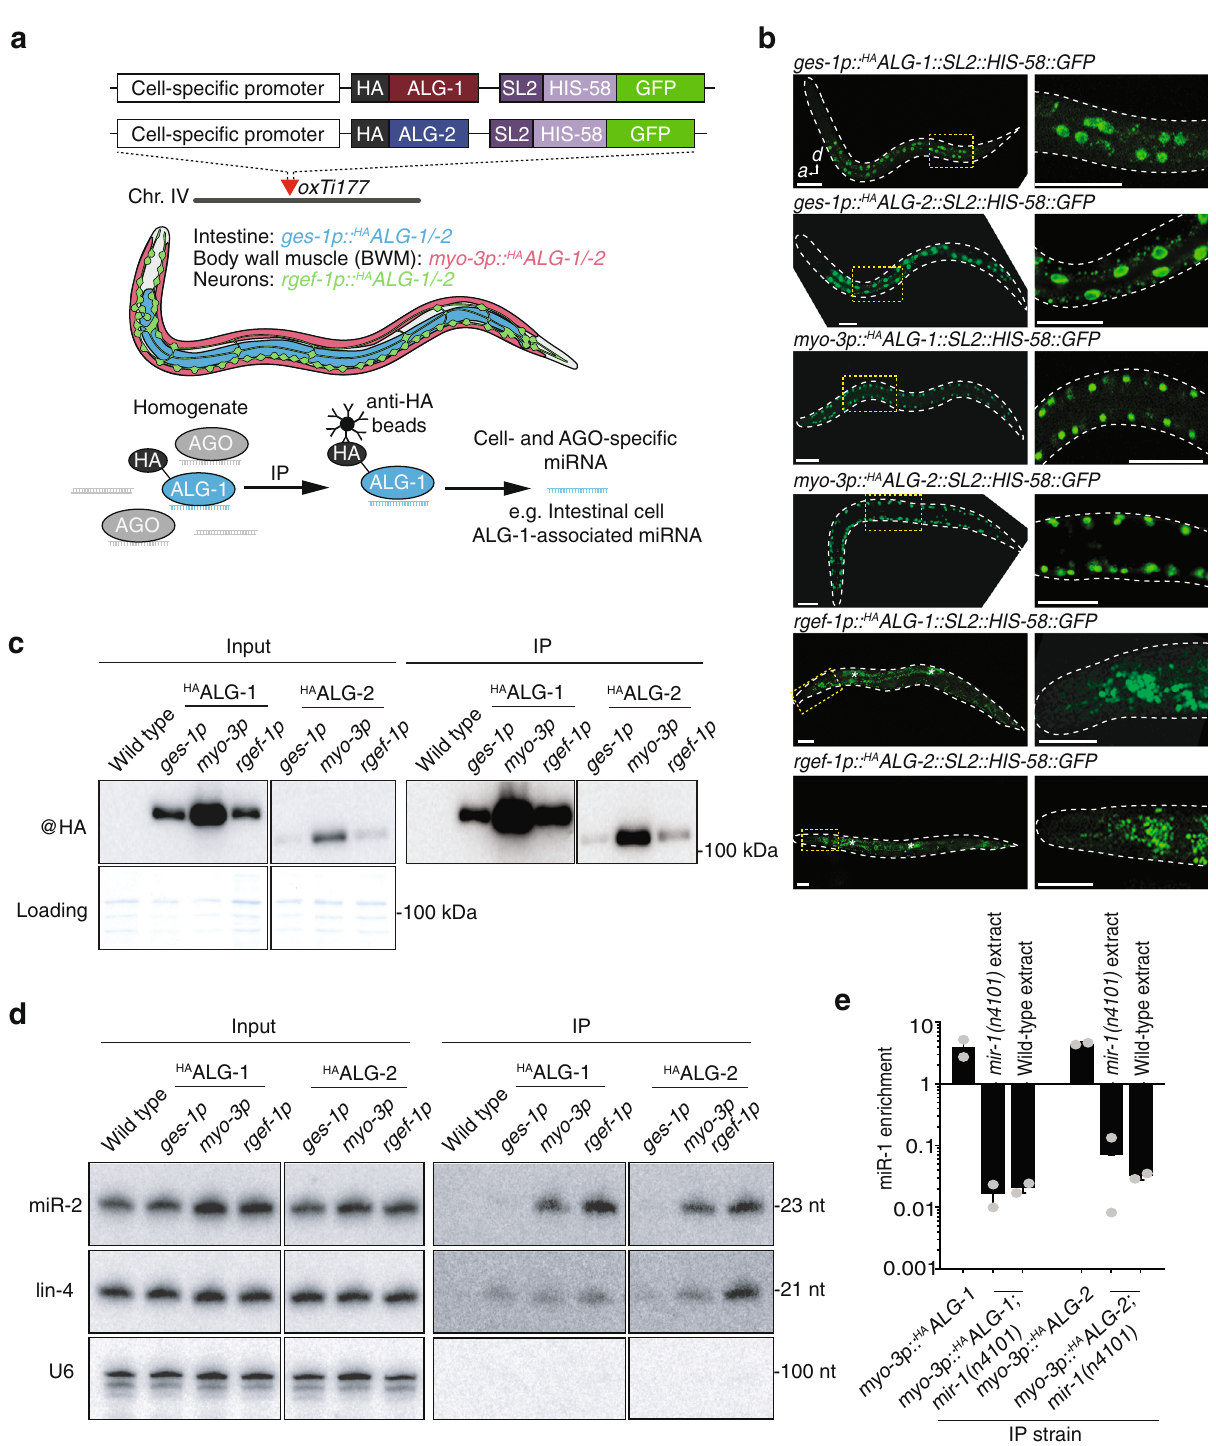
Fig. 1 Cell-type-speci fi c pro fi ling of AGO-loaded miRNAs. a Overview of cell-type-speci fi c miRNA pro fi ling technique. HA-tagged copies of ALG-1 or ALG-2 were driven by cell-type-speci fi c promoters, allowing immunoprecipitation of AGO-loaded miRNAs from individual tissue types from total worm homogenates. b Whole animal fl uorescence images of cell-type-speci fi c HA ALG-1 and HA ALG-2 lines demonstrating speci fi c expression from intestine, body wall muscles, or neurons. Scale bars, 50 µ m. Asterisks indicate intestine auto fl uorescence. Images are representative of >50 independent animals. c Western blot analysis of input (left) and immunoprecipitated (right) AGO complexes. All images are from the same blot and are equally exposed. Coomassie blue serves as a loading control. d RNA gel blot analysis of input (left) and AGO-immunoprecipitated miRNAs (right). U6 serves as a loading control. e Quantitative RT-PCR on immunoprecipitated AGO:miRNA complexes showing either enrichment >1 or lack of enrichment <1 of miR-1 immunoprecipitated with HA ALG1 or HA ALG2 in the genetic backgrounds and conditions indicated. Error bars represent + / − s.e.m. of three biological replicates. P values were calculated using one-way ANOVA with Dunnett ’ s multiple comparisons test. All immunoprecipitation experiments were repeated three times with similar results. HA hemagglutinin, SL2 splice leader sequence, GFP green fl uorescent protein, IP